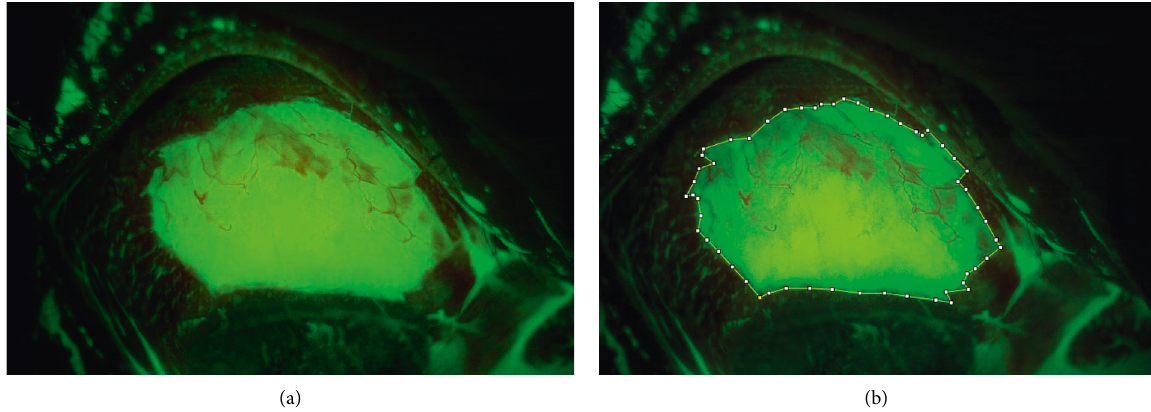
Figure 3: Photographs of the fluorescein-stained positive epithelial defect of conjunctiva after pterygium excision. (a) Original photo. (b) Photo after manual delineation of the fluorescein stained-positive conjunctival epithelial defect using ImageJ